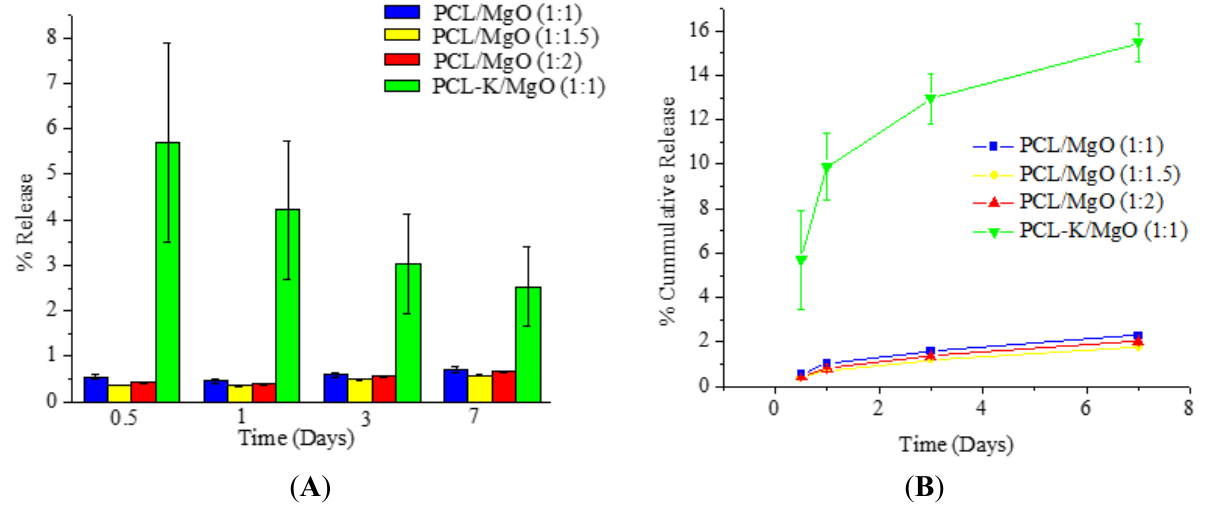
Figure 7. Release profile of Mg by using ICP-OES, n = 3. ( A ) Percentage release of